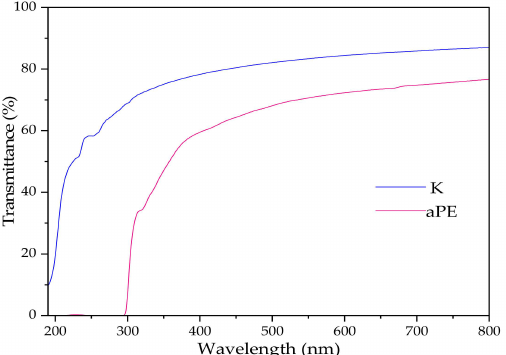
Figure 9. Transmittance curves at UV-Vis range of K and aPE samples.